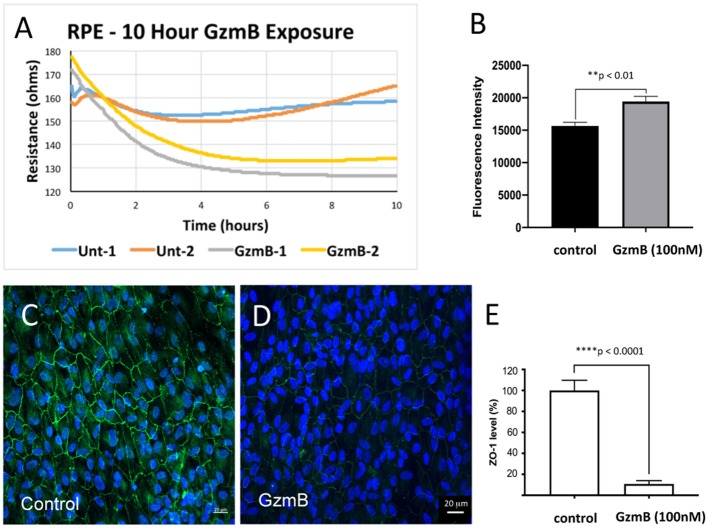
Lowered trans-epithelial resistance and increased FITC-dextran flux after GzmB stimulation on primary RPE cells grown on transwell inserts. To test the primary RPE barrier function, cells were grown on transwell inserts and stimulated with GzmB at 100 nM. (A) Trans-epithelial resistance measurements on resting cells ranges from 160 to 180 ohms. After initiation of GzmB stimulation (time = 0), the resistance of RPE cultures decreases to 135–125 ohms (time = 10 h) as shown by yellow and gray traces. The control cells maintained resistance at 160–165 ohms (time = 10 h) as shown by the blue and orange traces. (B) FITC-dextran flux assay demonstrated increased FITC-dextran fluorescence intensity measured in the lower compartment of GzmB stimulated wells compared to control wells. (C–E) After the flux assay, the membranes on which cells were attached were cut out and subjected to immunocytochemistry. Strong ZO-1 immunolabeling on primary RPE cells on transwell insert membrane in control wells (0 nM GzmB) after 5 h shown in (C,D) in experimental wells (100 nM GzmB) after 5 h of GzmB stimulation. (E) The ZO-1 immunoreactivity was quantified in controls and GzmB stimulated wells and an independent-sample T-Test (N = 6) between control and GzmB-treated group was undertaken and graphed as mean ± SEM; ****p < 0.0001; **p < 0.01. DAPI (405 nm) labeling of nuclei is shown in blue.